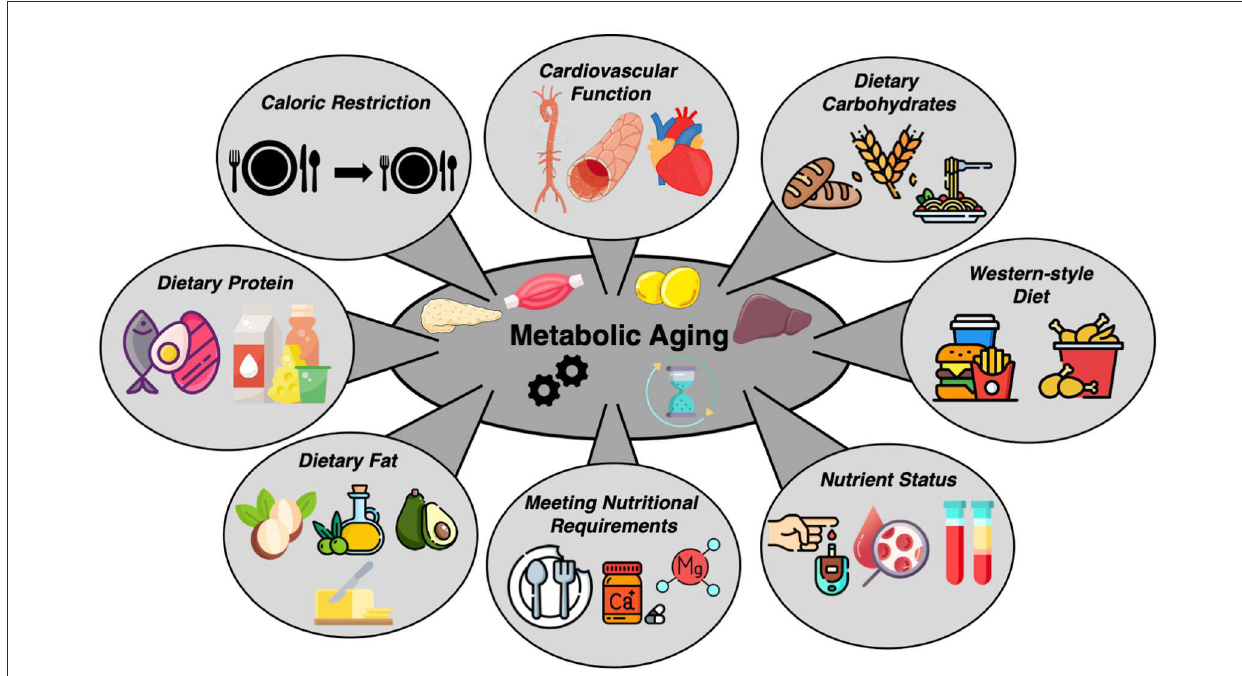
FIGURE1 Various nutritional interventions and nutrient statuses that influence metabolic health with aging. This figure summarizes a variety of studies included in the call for papers on “Nutrition and Metabolic Aging.” This collection of papers represents studies focused on caloric restriction, consumption of a Western-style diet, macro and micronutrient intake, nutrient status and cardiovascular health, all within the context of metabolic